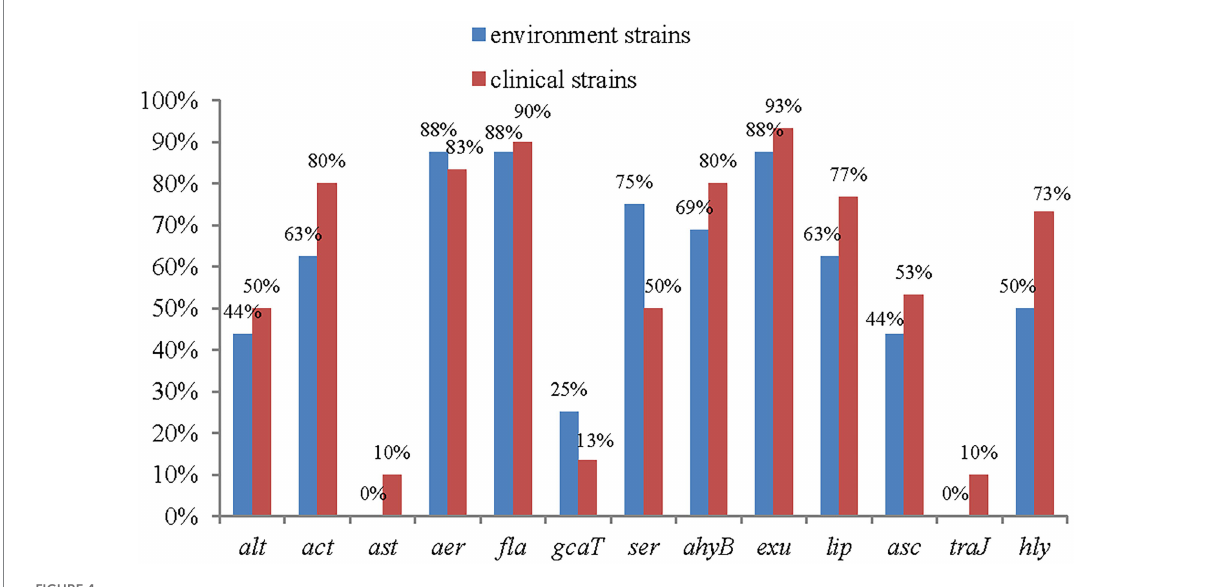
FIGURE 4 The distribution of virulence genes in clinical strains and environment strains of A. veronii .